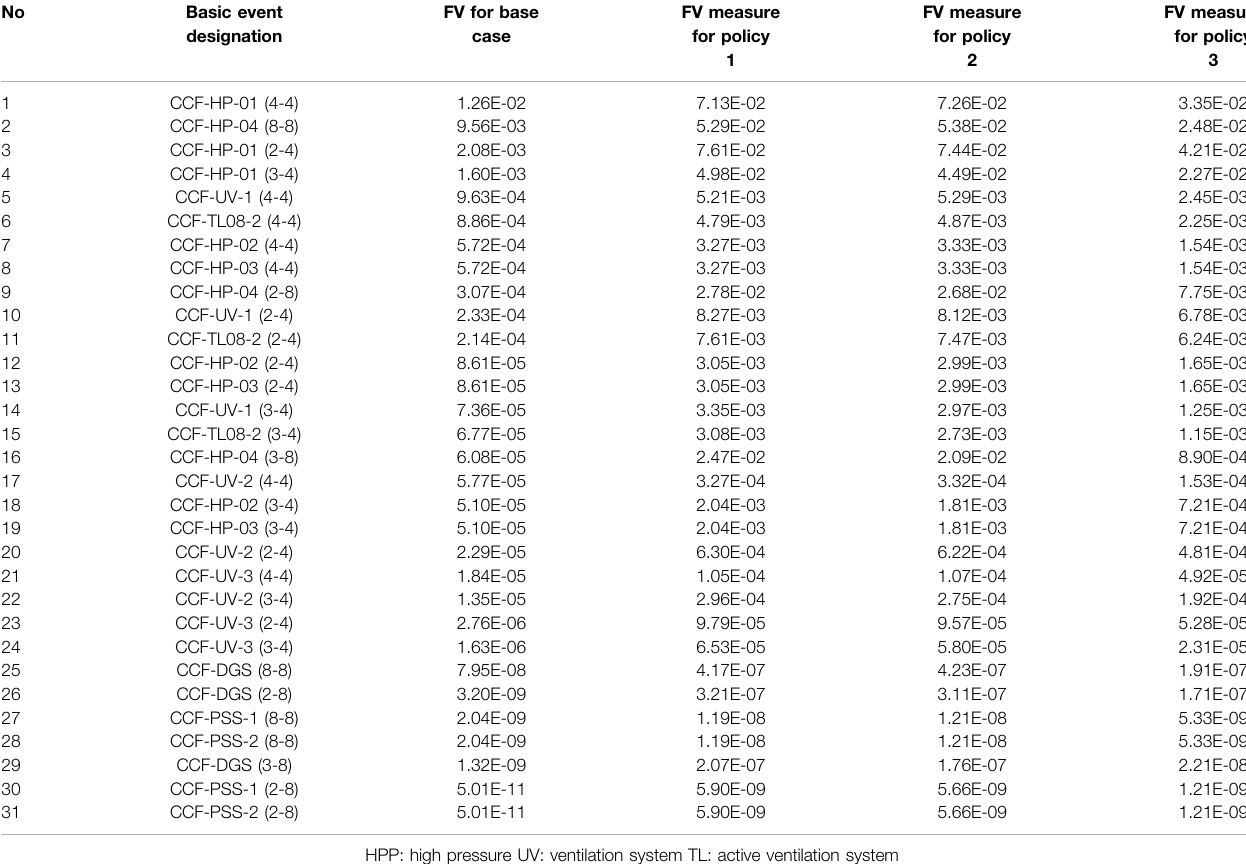
TABLE 9 | FV importance measure for selected basic events of “ F ” function of ECCS of VVER1000/V446 NPP.